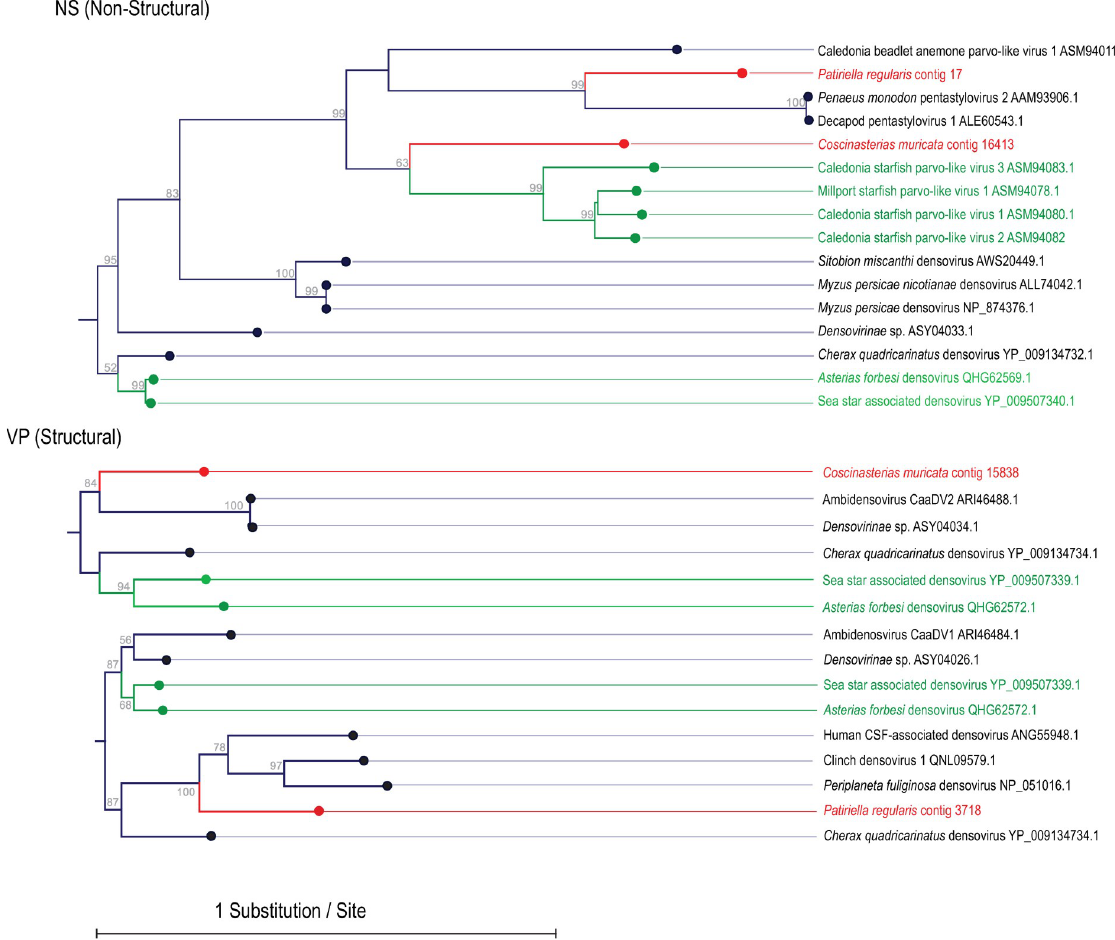
Fig 3. Phylogenetic representation of Patiriella regularis and Coscinasterias muricata -associated densoviral genome fragments. The trees are based upon 170 amino acid (Non-Structural), 211 amino acid (Structural; middle), and 104 amino acid (Structural; bottom) alignments performed using the CLC Sequence Viewer version 8.0. The trees were constructed with neighbor joining and Jukes-Cantor distance, where bootstrap values (1000 reps) are indicated above nodes. Red labels indicate sequences obtained in this study, while green labels indicate sequences obtained from asteroids in other